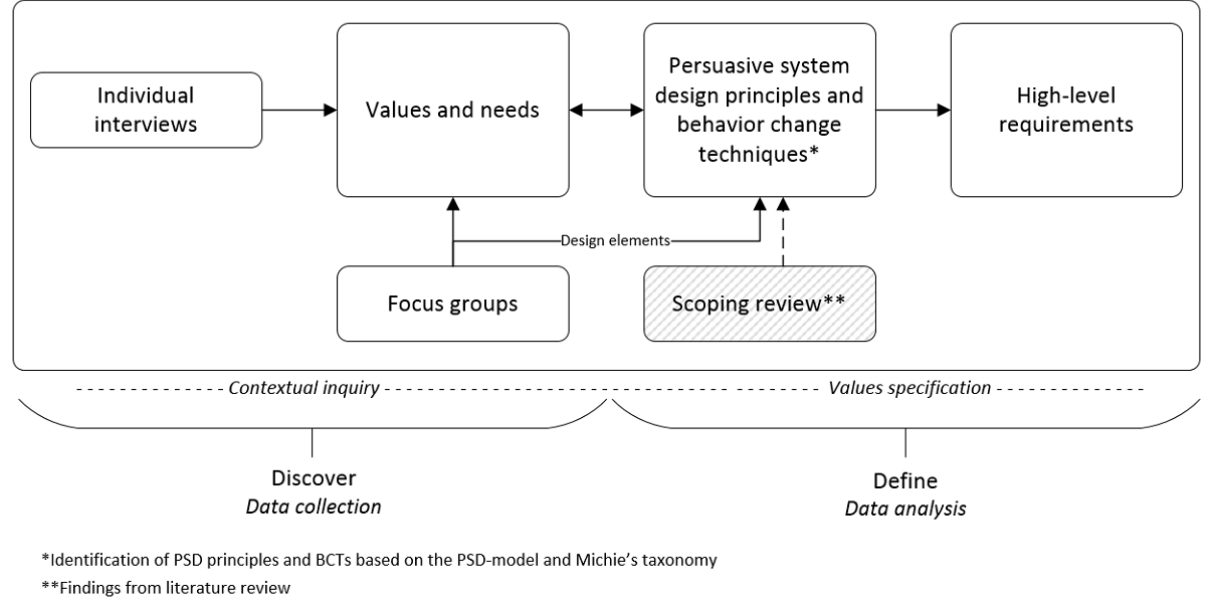
Figure 3. Value identification and translation of identified values and needs into persuasive system designs, behavior change techniques, and high-level requirements. BCT: behavior change technique; PSD: persuasive system